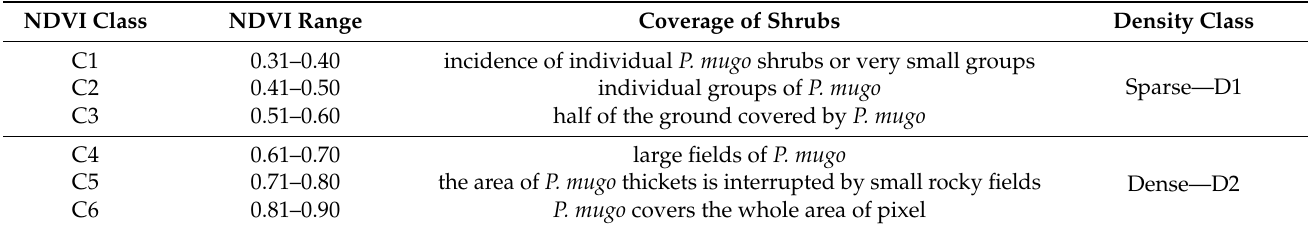
Table 3. Classification of pixels with P. mugo into density classes based on their average NDVI values. NDVI